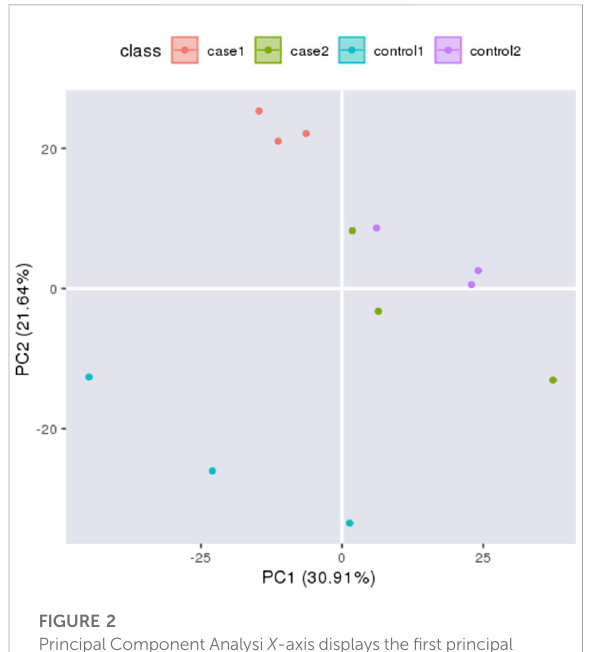
FIGURE 2 Principal Component Analysi X -axisdisplaysthe fi rst principal component and y -axis displays the second principal component. The orange circles indicates experiment I, the green circles indicatesexperimentII,thebluecirclesindicatescontrolIand the purple circles indicates control II.